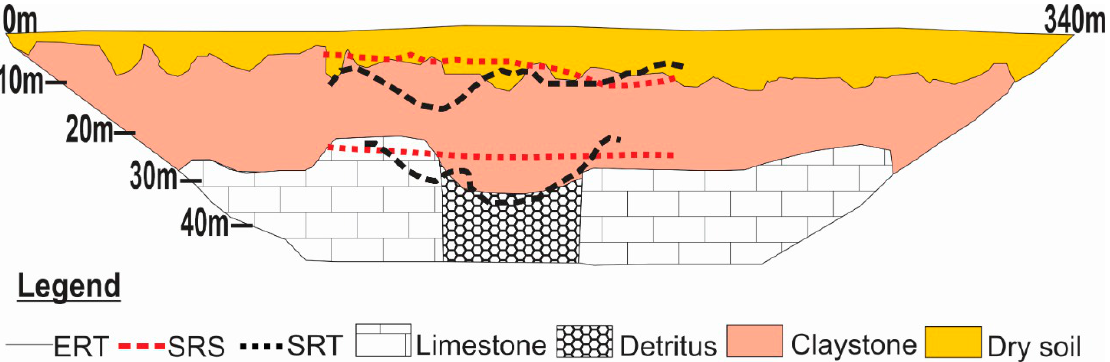
Figure 15. Interpreted geological model based on ERT, SRS and SRT methods.